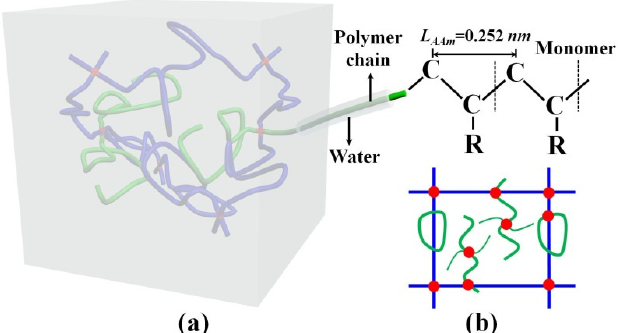
Figure 5. ( a ) Schematic diagram of the polymer network-water structure of PAAm hydrogel. ( b ) Schematic diagram of the main polymer network and the dangling chains (Blue chains represent the main network; Green chains are the dangling chains; Red joints are the crosslinkers.).